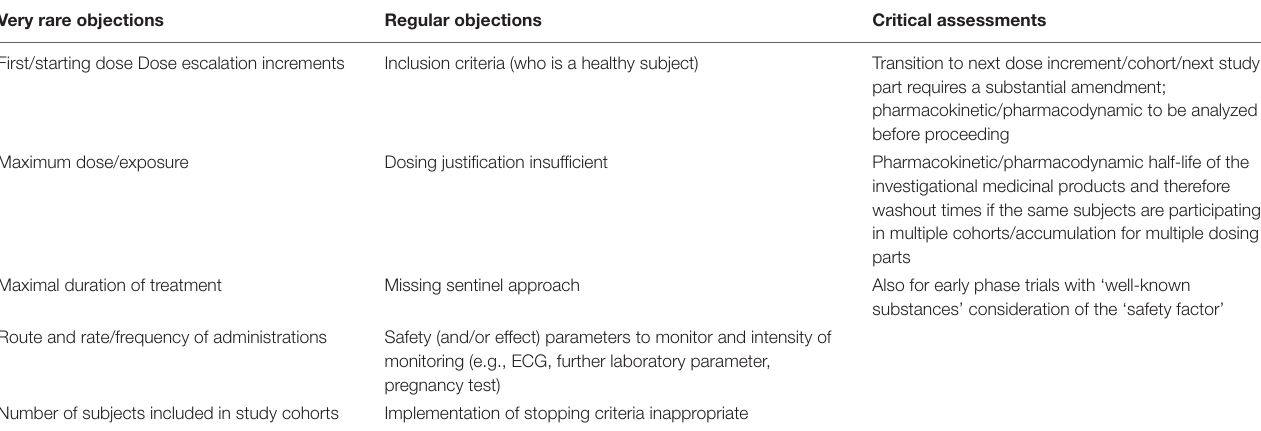
TABLE 1 | Categorical reasons for the provision of GNAs issued by the